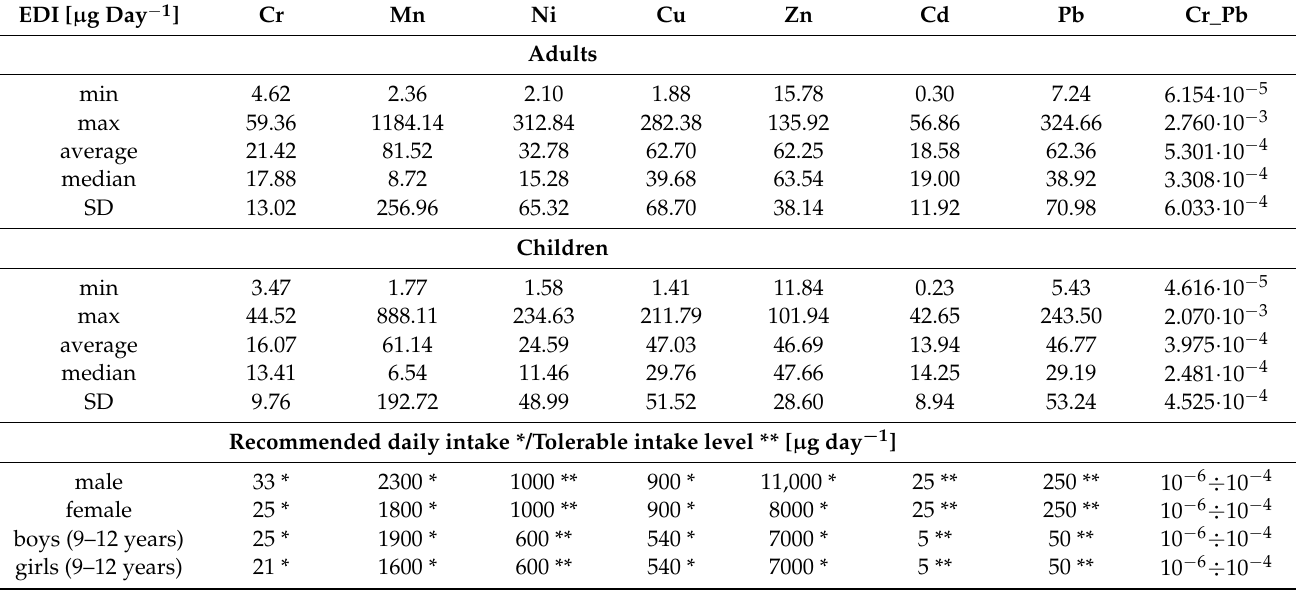
Table 7. Estimated daily intake values and recommended daily intake/tolerable intake level for adults and children, as well as carcinogenic risk induced by lead content